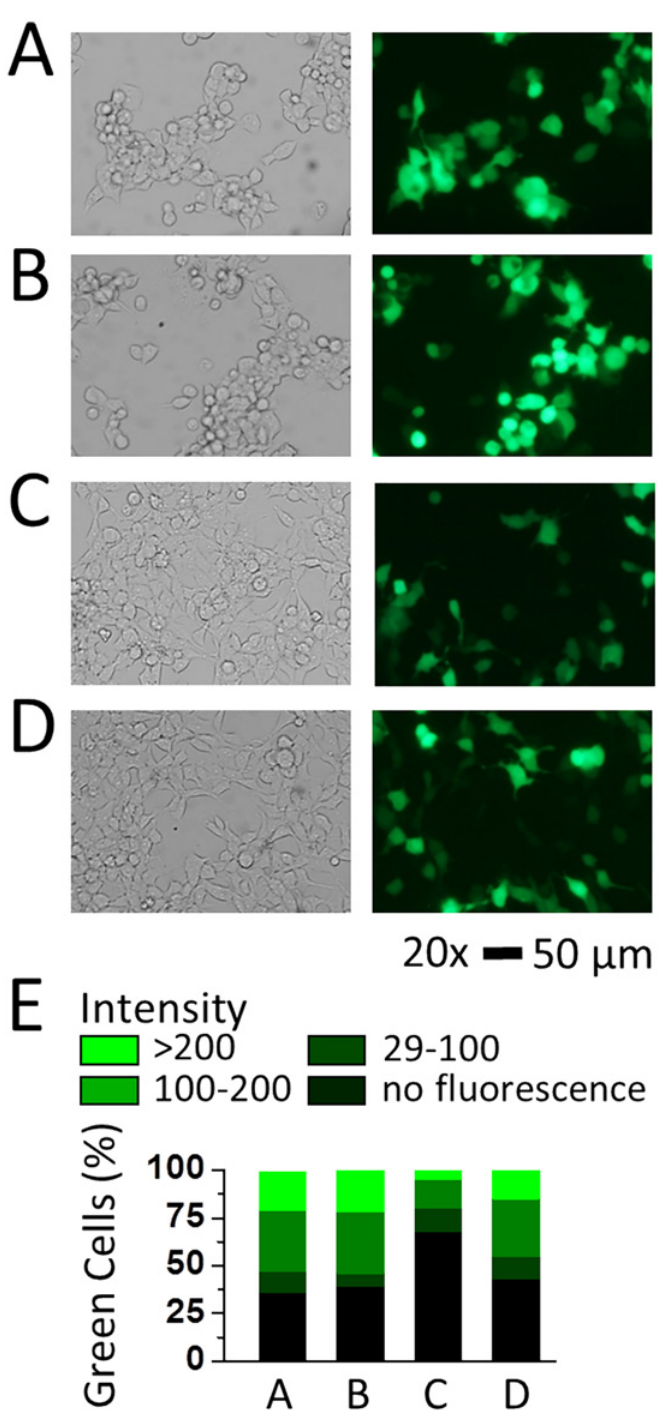
Fig 4. Transfection of the GFP plasmid in HEK-293S cells with different reagents and the expression of GFP at 33°C. Bright-field and fluorescence images (34.8x magnification, scale bar = 50 μ m) of HEK-293S cells taken at the 48th hour after transfection. Transfection of HEK-293S cells as in images (A) to (D) was carried out using Lipofectamine 2000, Lipofectamine LTX & PLUS, Metafectene EASY with Opti-MEM and Metafectene EASY with DMEM with 10% FBS, respectively. In each of the transfections, 2 μ g GFP plasmid for a 35 mm Petri dish was used. On day 1, all transfected dishes were incubated at 37°C; on day 2, these dishes were transferred to a 33°C incubator. Based on these images, the transfection efficiency for